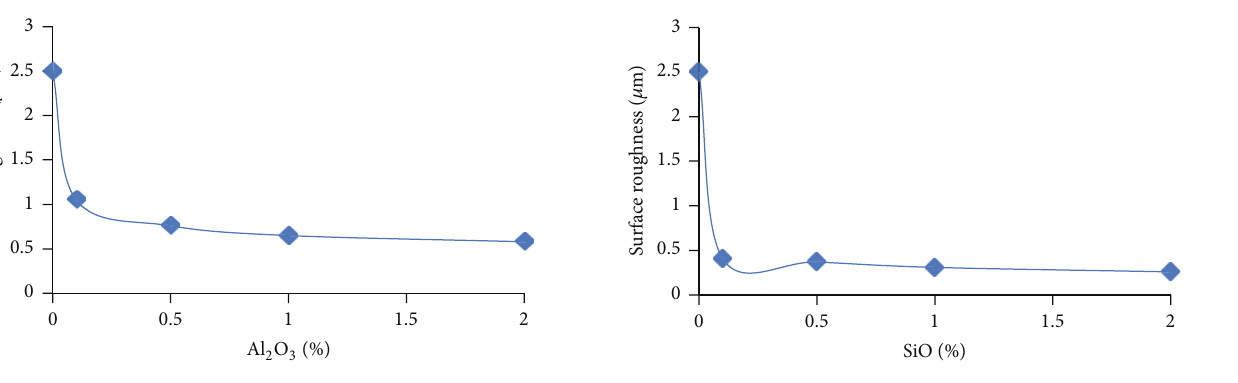
Figure 9: Variation in average surface roughness of EN-coatings as a function of Al 2 O 3 with surfactant (SLS) concentration in the EN bath.